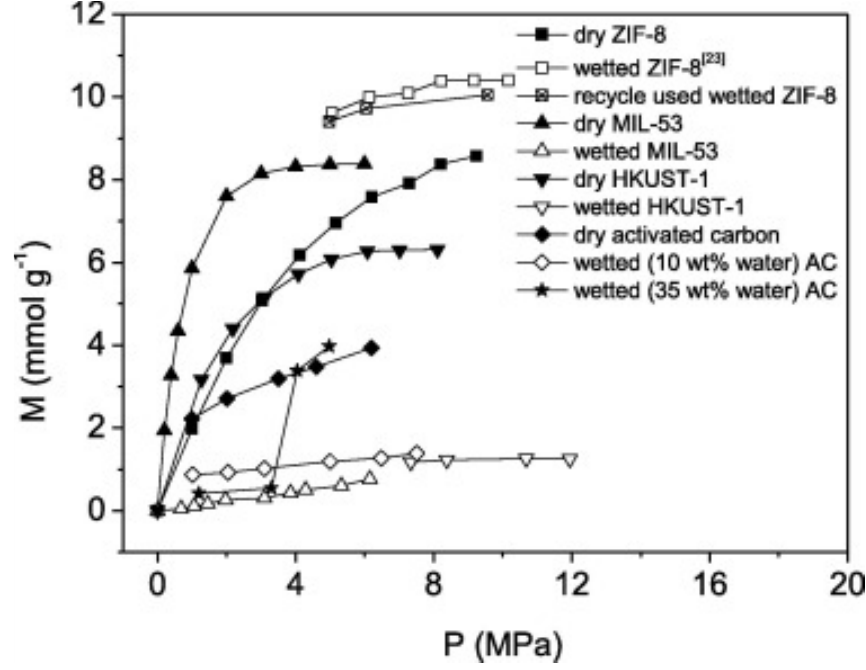
Figure 7. Methane adsorption in dry ZIF-8, 30 wt% wetted ZIF-8, once-recycled 30 wt% wetted ZIF-8, dry and 25 wt% wetted MIL-53, dry and 30 wt% wetted HKUST-1 and nanoporous activated carbon (AC) with water contents of 0, 10 and 35 wt% at 274.15 K (Reprinted from [77], Copyright (2018), with permission from Elsevier).